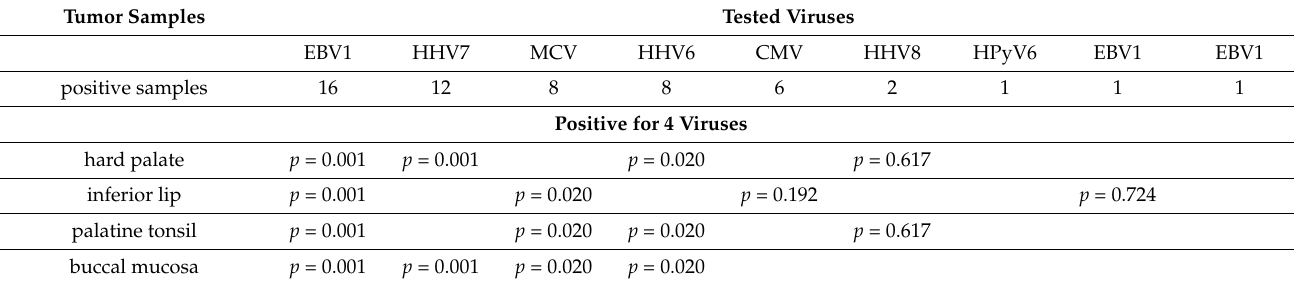
Table 1. Correlations between tumor samples and the number of positive viruses .